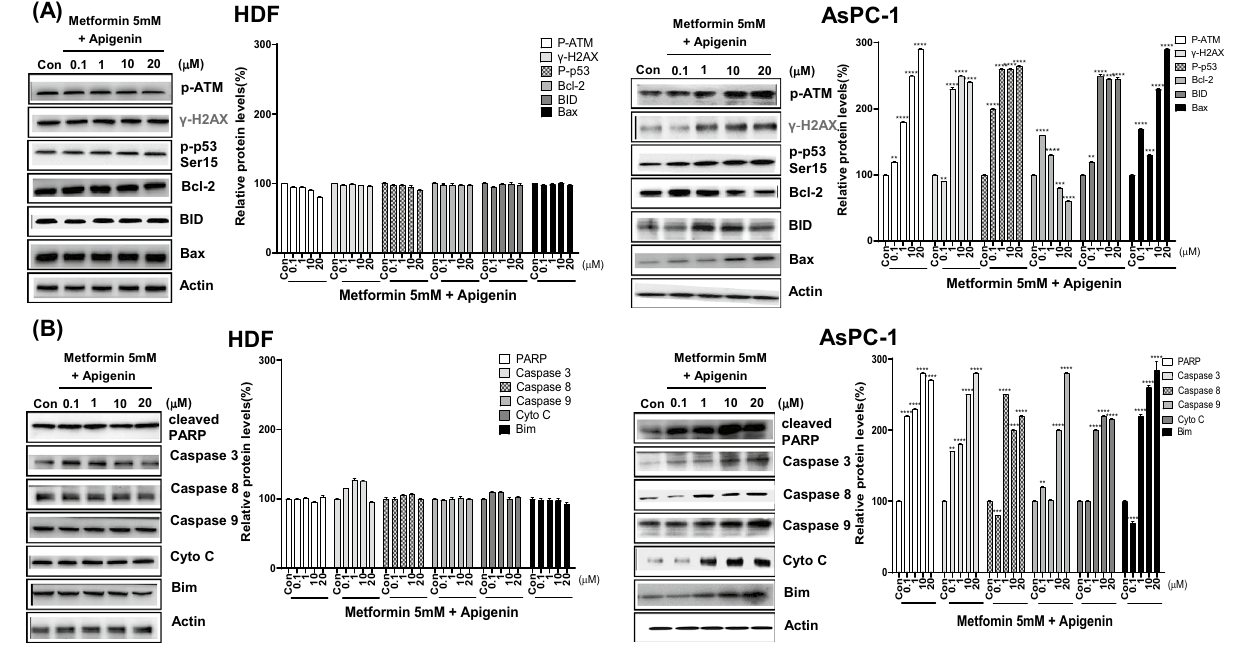
Figure 5. Levels of DNA damage- and apoptosis-related proteins in metformin and apigenin-cotreated AsPC-1 and HDF cells. AsPC-1 and HDF cells were treated with metformin (5 mM) and apigenin (0.1, 1, 10 or 20 μM) for 48 h. Cell extracts were prepared and subjected to western blot analysis. DNA damage-related proteins were analyzed with anti-p-ATM, H2AX, and p-p53 (Ser15) antibodies. Apoptosis-related proteins were analyzed with anti-BID, Bax, cleaved-PARP, cleaved-caspase 3, 8, 9, cytochrome C, and Bim antibodies. Three different measurements were performed for each sample. Statistical significance is indicated as * p < 0.05, ** p < 0.01,